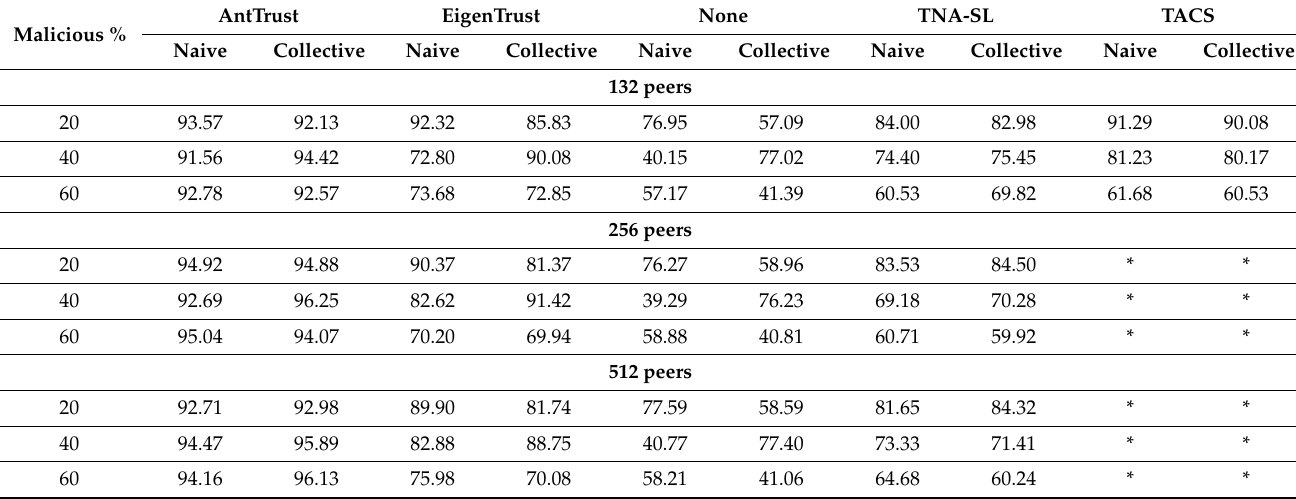
Table 2. The success rate for 2500